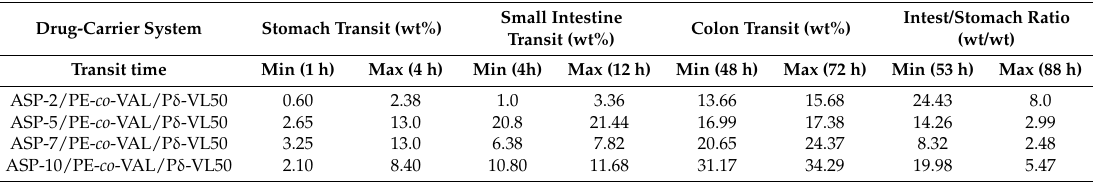
Table 7. Estimated distribution of the cumulative ASP released from ASP/PE- co -VAL/P δ -VL50 drug-carrier systems on the principal digestive